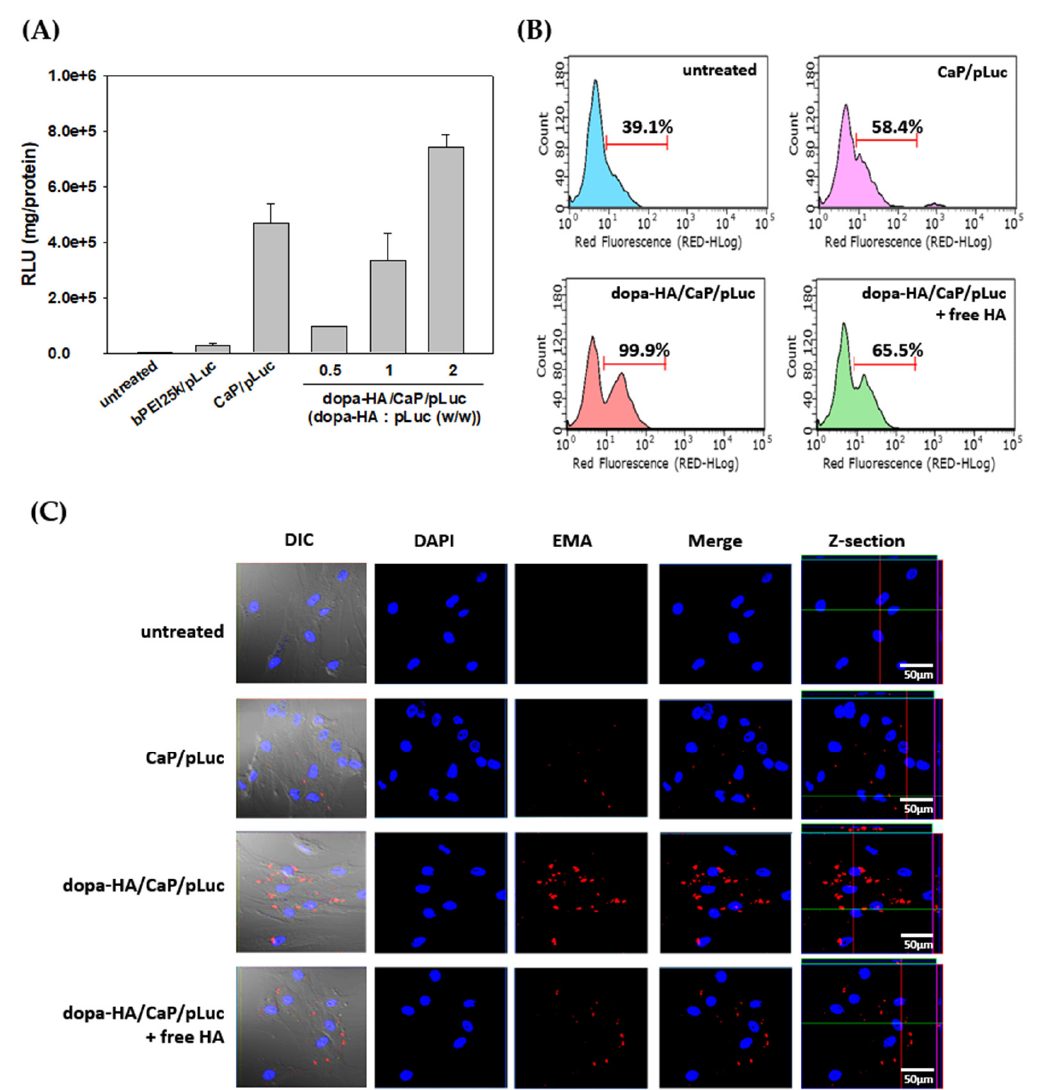
Figure 3. ( A ) Transfection e ffi ciency of dopa-HA / CaP / pLuc (w / w = 2) in human mesenchymal stem cells (hMSCs). The bPEI 25 kDa (bPEI25k / pLUC, w / w = 1) and untreated cells were used as controls. Flow cytometry ( B ) and confocal microscopy ( C ) results of the cellular uptake of CaP / pLuc and dopa–HA / CaP / pLuc (w / w = 2) in the absence or presence of free HA.